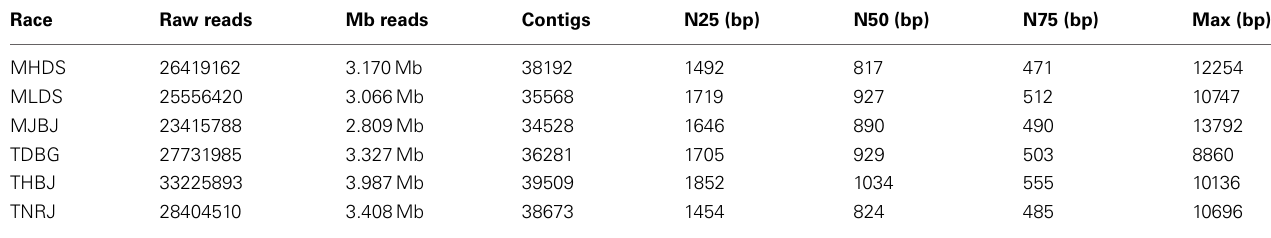
Table 2 | Illumina RNAseq data and assembly